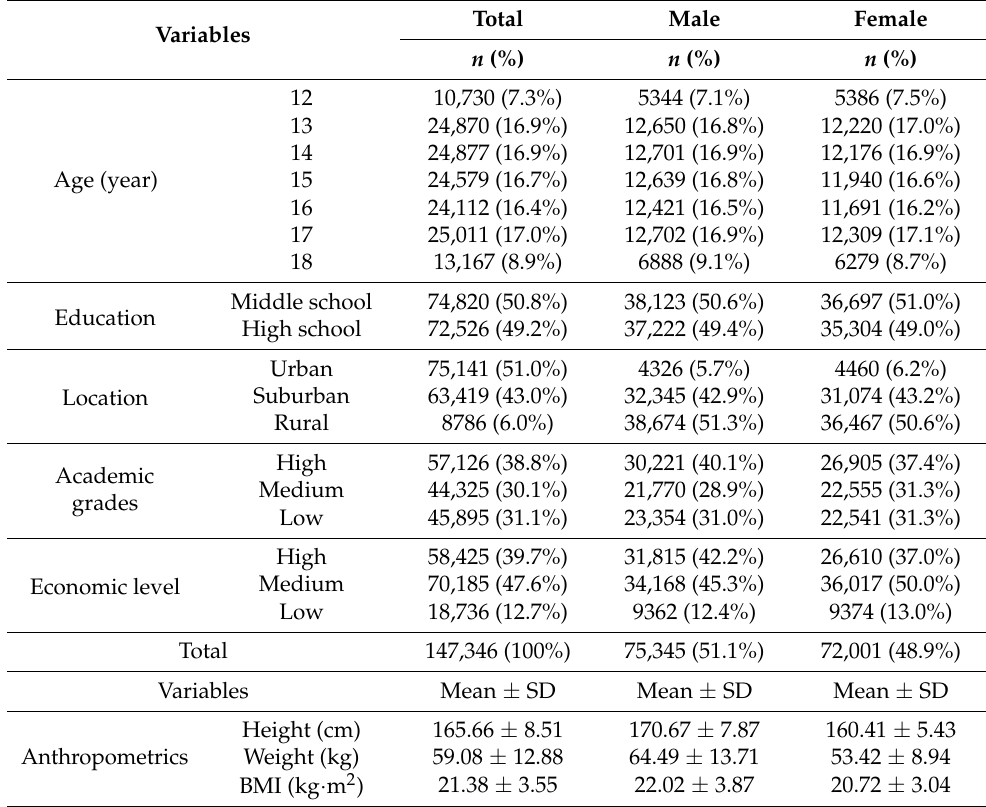
Table 1. The general characteristics of the subjects ( n = 147,346). Variables